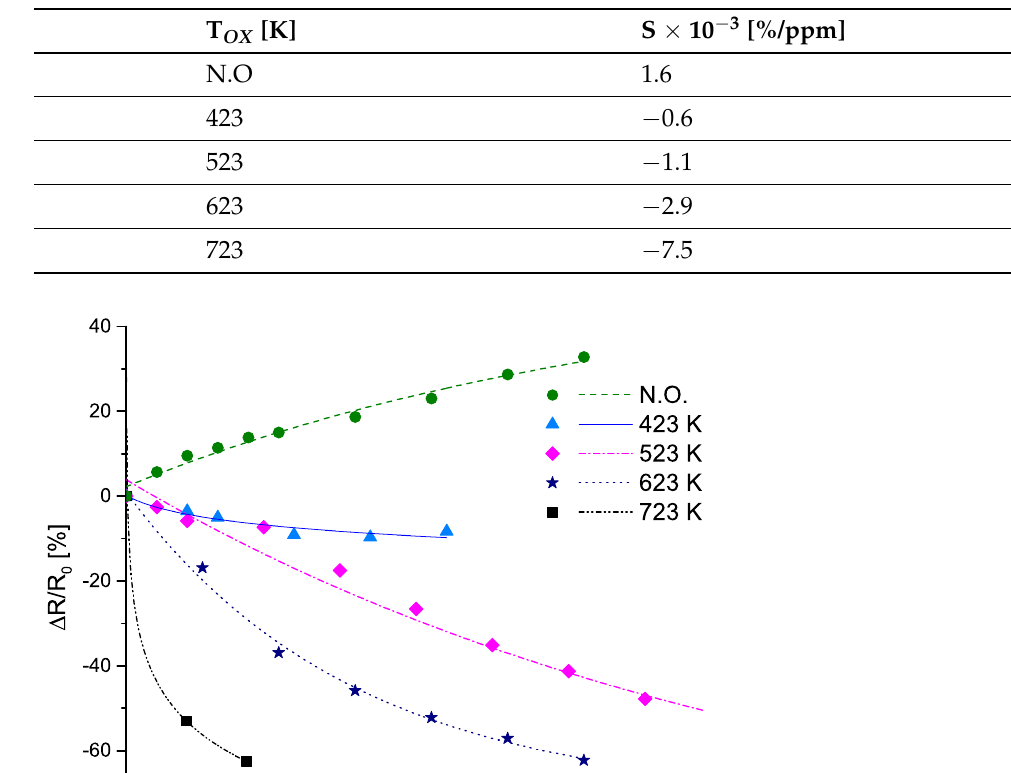
Table 1. Estimated sensitivities of sensors oxidized at different temperatures (N.O. stands for not oxidized) as calculated by approximating a linear response below 1.5 × 10 4 ppm.